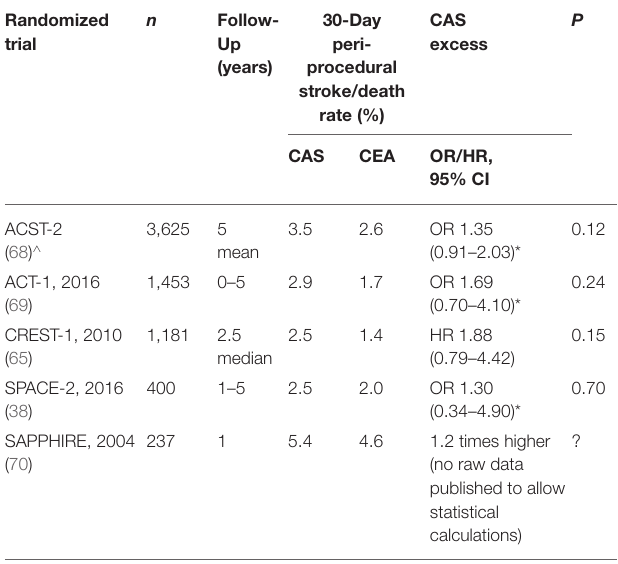
TABLE 2 | Peri-procedural rate of stroke or death with CAS compared to CEA in the largest randomized trials of patients with asymptomatic carotid stenosis. Randomized